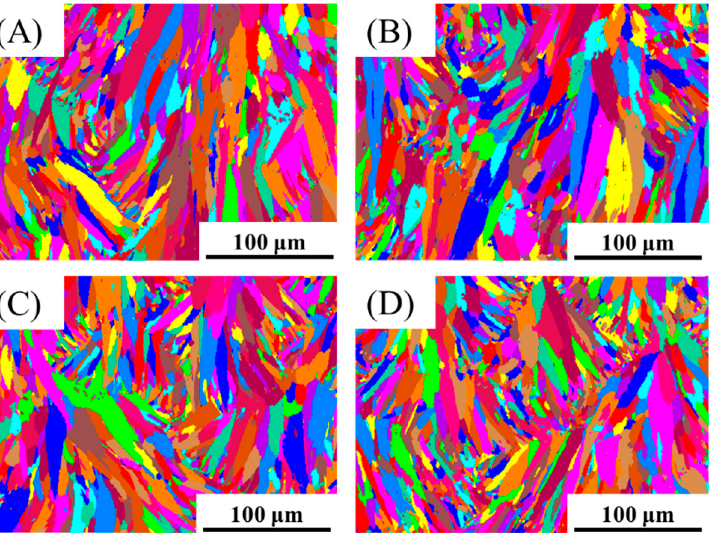
Figure 8. EBSD images of the samples in the as-printed status: ( A ) Process A2; ( B ) Process A3; ( C ) Process B2; ( D ) Process B3.